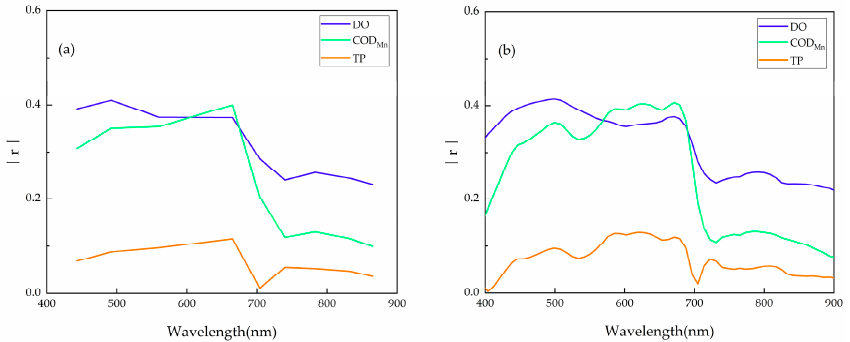
Figure 6. The absolute value of r between water quality parameters and MSI ( a ) and AHSI ( b ) equiv- alent reflectance.